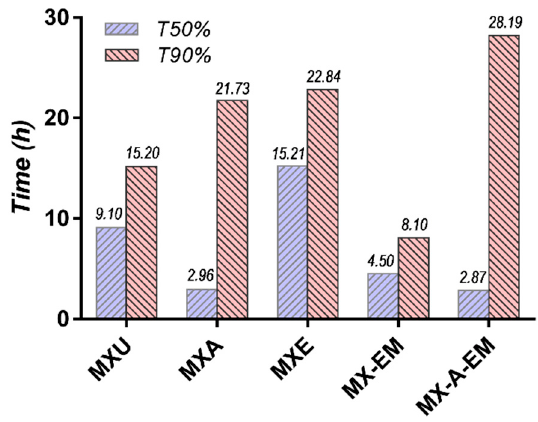
Figure 15. Dissolution time of 50%, respectively 90% of the dose.